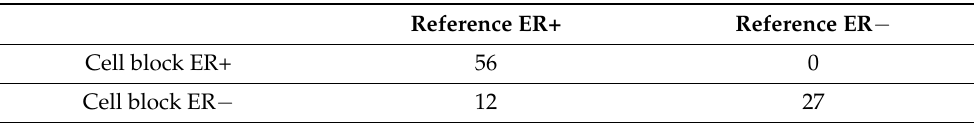
Table 6. Comparison of estrogen receptor (ER) expression in cell block material and reference biopsy or excision